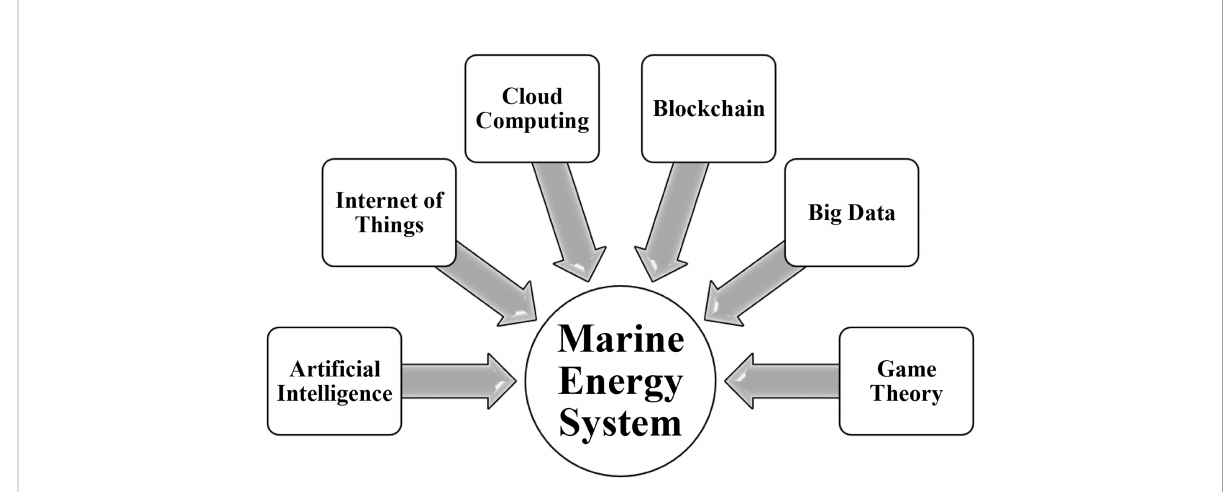
FIGURE 2 Recent technology in the fi eld of Marine energy